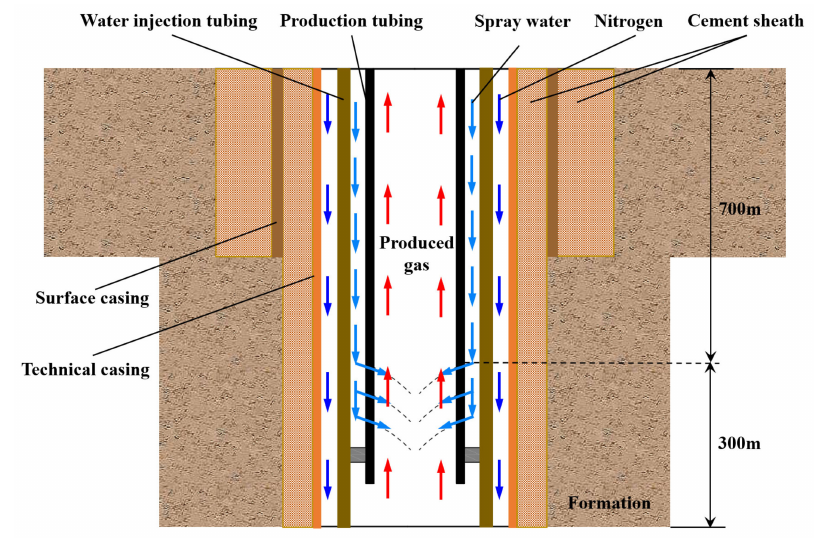
Figure 5. Concentric tubing water injection spray cooling